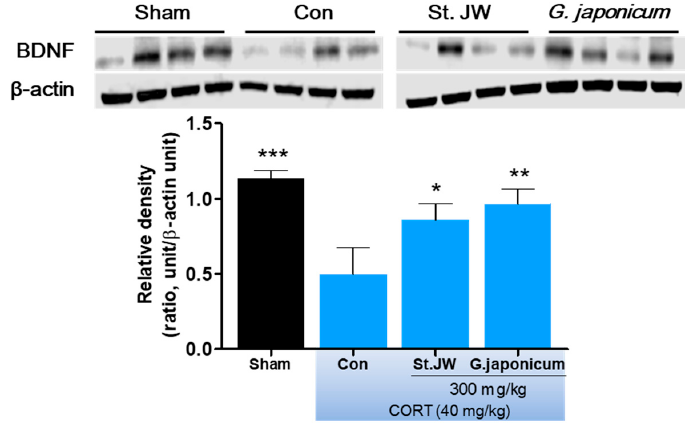
Figure 6. Effect of G. japonicum extract on hippocampal BDNF quantification by western blotting. CORT injections significantly decreased BDNF expression in the hippocampus, while treatment with 300 mg/kg G. japonicum extract significantly increased it. Results are presented as mean ± SEM. *** p < 0.001, ** p < 0.01, and * p < 0.05 versus the CORT-injected control group (Con). BDNF, brain-derived